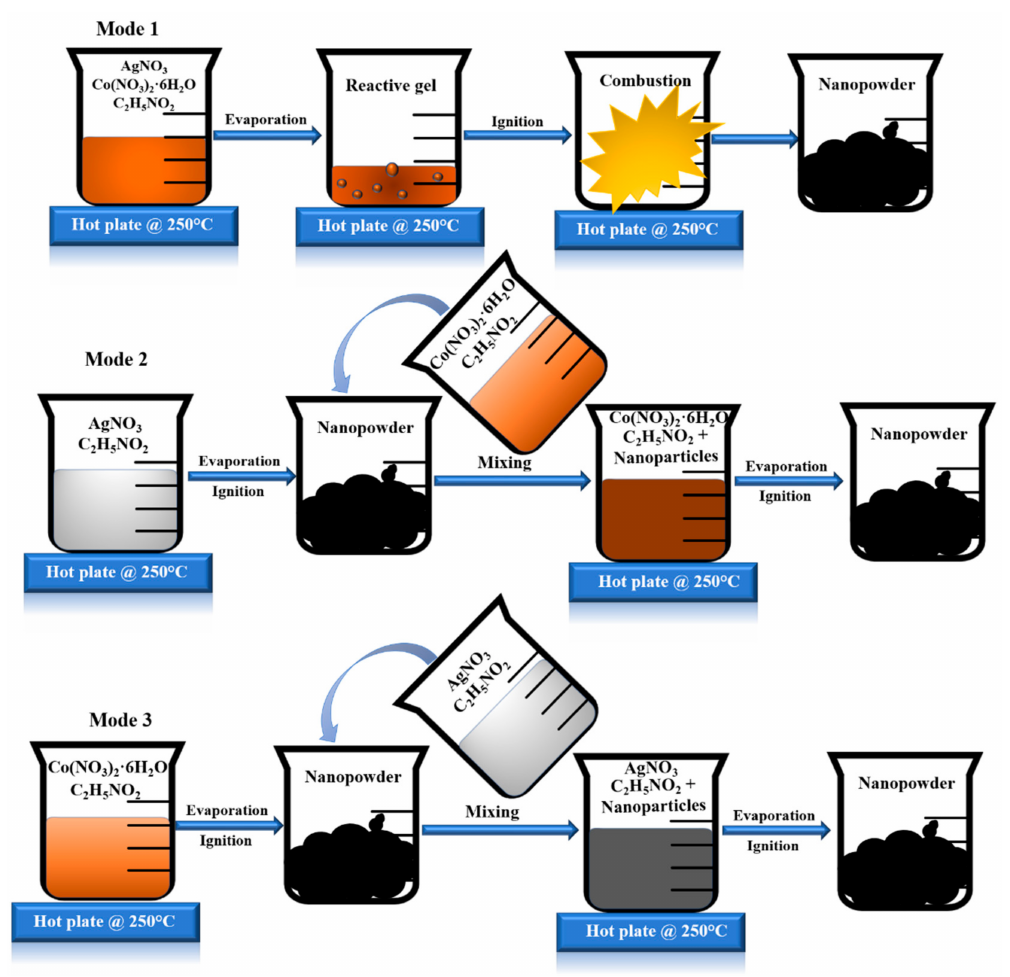
Scheme 1. Schematic representation of three different modes of solution combustion